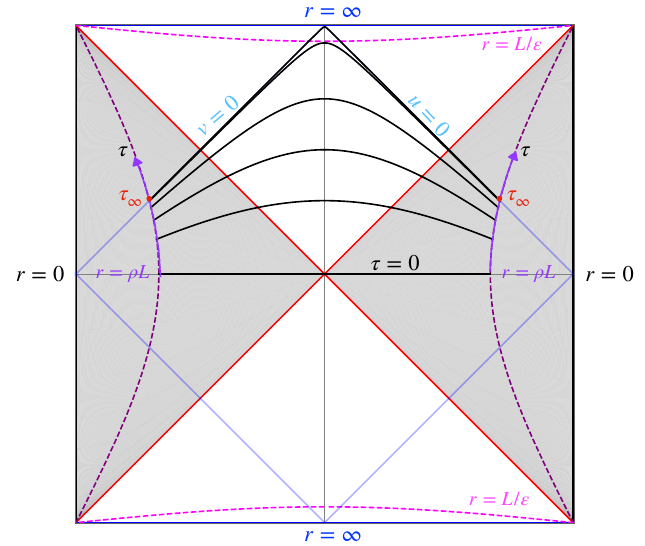
Figure 2 . Extremal surfaces joining the left and right stretched horizons at the boundary time τ are denoted by the black